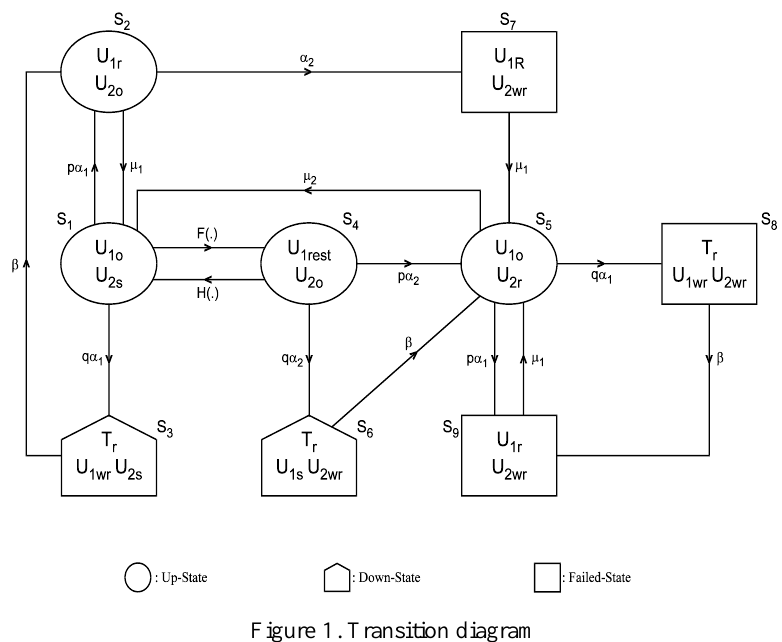
Figure 1. Transition